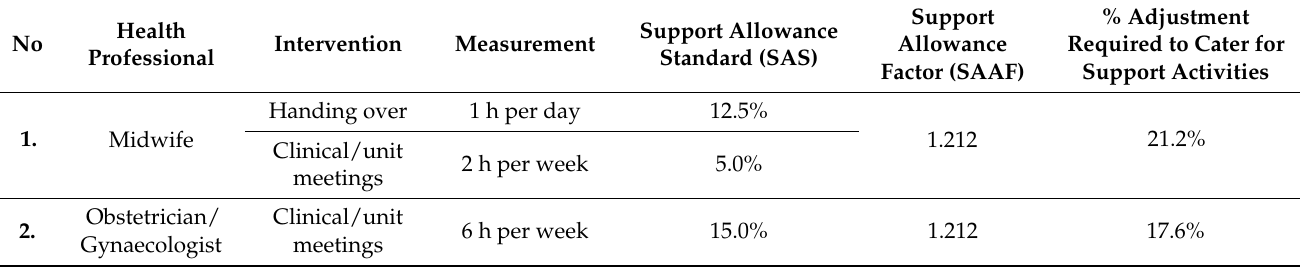
Table 5. Exploring the effect of incorporating support activities in the needs-based